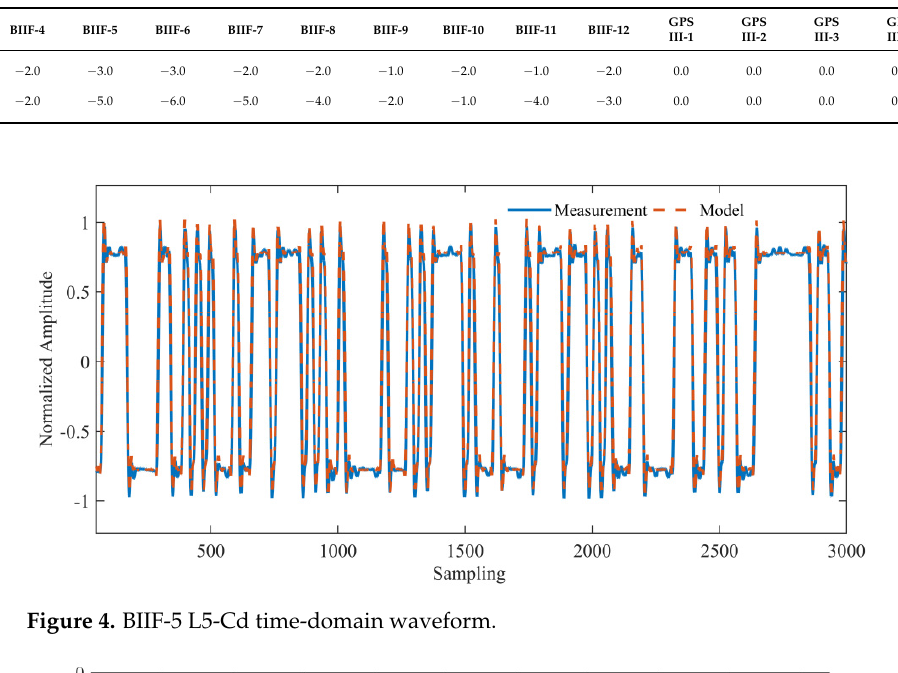
Table 1. Navigation payload transmission channel digital distortion.